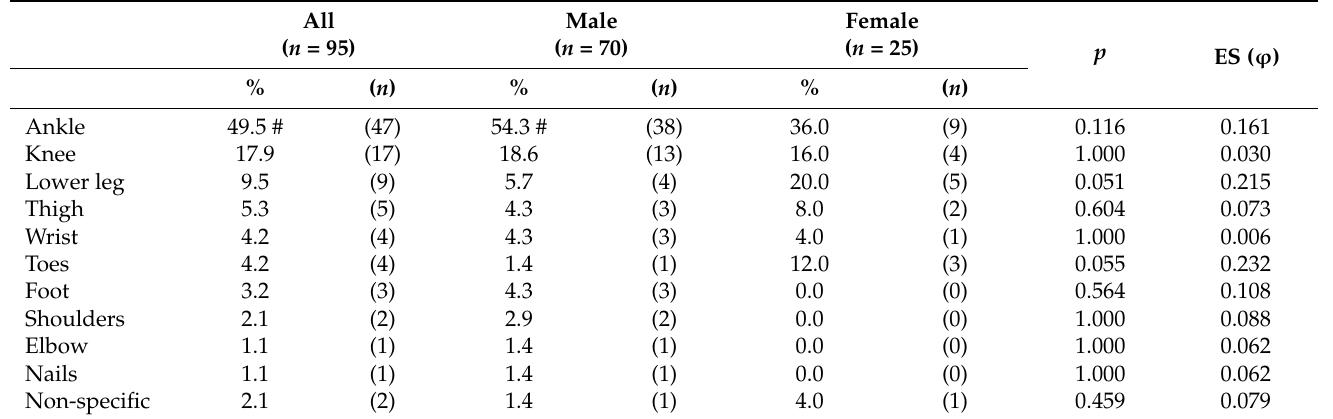
Table 1. Body region of injuries in male and female trail